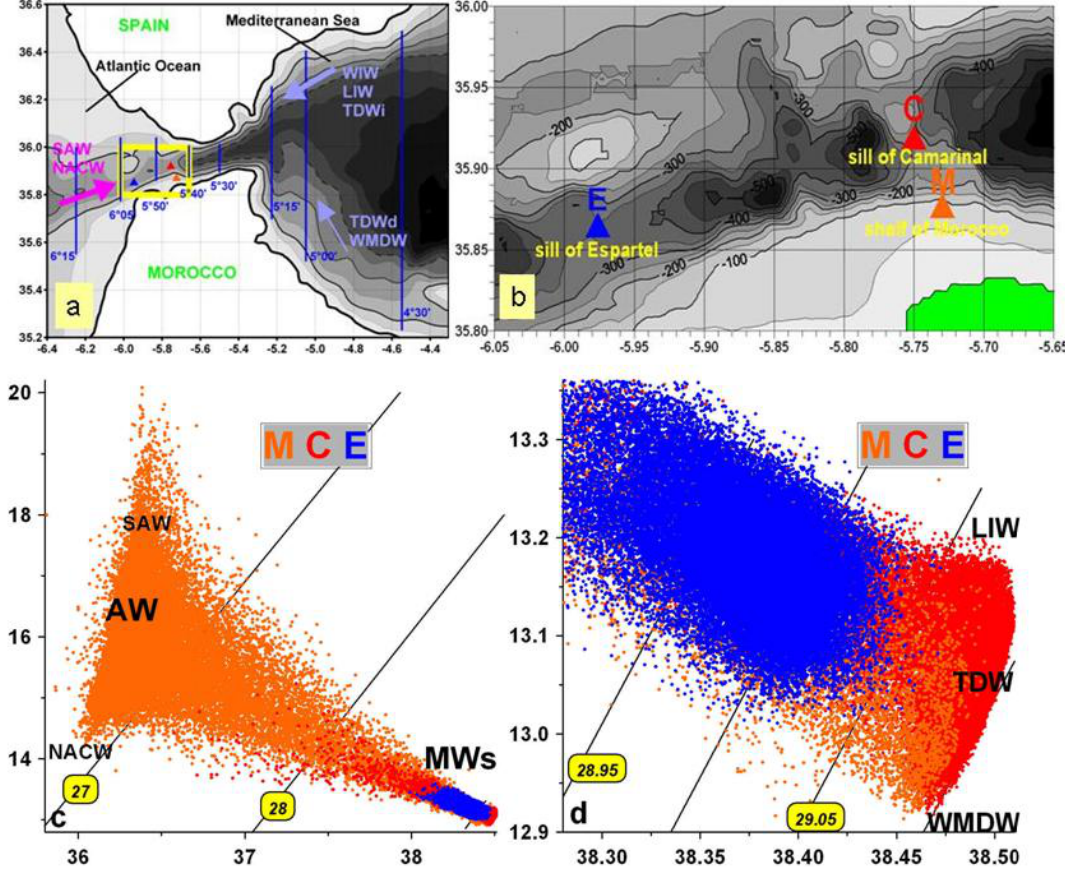
Fig. 1. (a, b) Locations of the CTDs moored at the sill of Camarinal (C, red triangle, 270m), on the shelf of Morocco (M, orange triangle, Figure 1 80m) and at the sill of Espartel (E, blue triangle, 360m). The blue lines schematise the GIBEX sections (M09) and the waters acronyms are defined in the Discussion section. (c) 2 - S diagrams for the whole 2004–2008 period and over the whole data range at M, C and E. (d) 2 - S diagrams for the whole period and in the MWs ranges at M, C and E; WIW is not mentioned since it is roughly located near the AW-TDW mixing line, and is expected to outflow more to the north